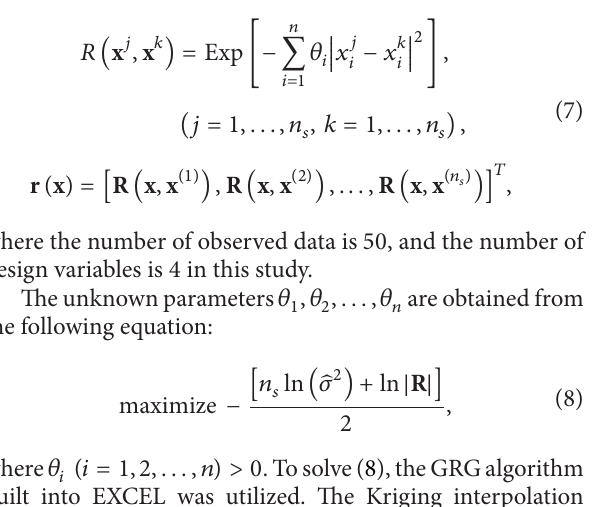
Figure 6: Buckling and durability analysis result of optimum Al6082M